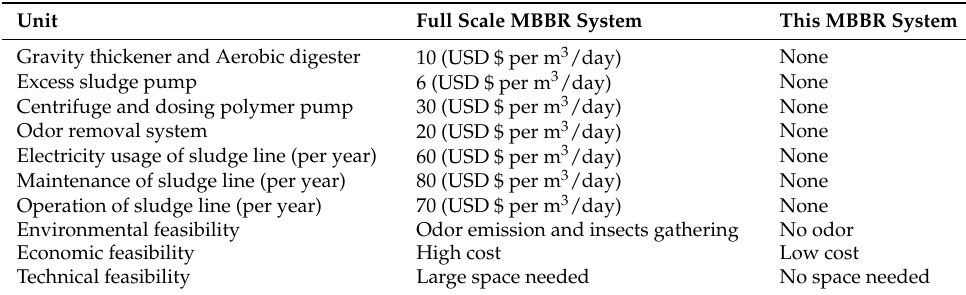
Table 4. Comparison of cost reduction, limitation and advantages between the system in this study and an actual operated MBBR